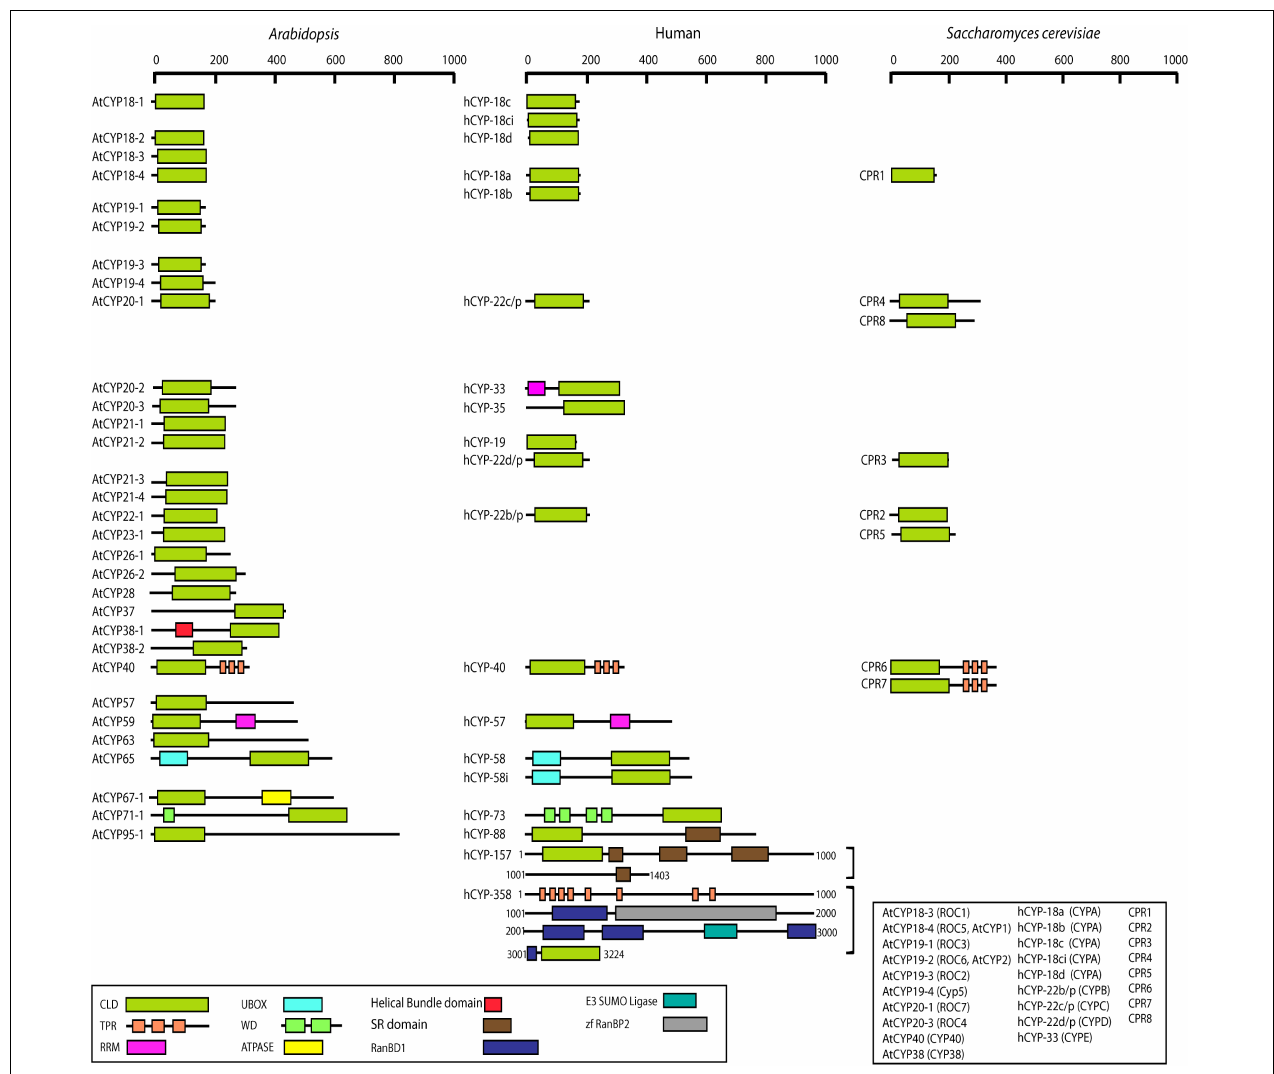
FIGURE 1 | Comparative analysis of domain architecture of Arabidopsis cyclophilins with their orthologs in human and Saccharomyces cerevisiae . The amino acid residues that define the protein domains are designated according to Galat (2004), Wang and Heitman (2005), Kumari et al. (2015), and Schiene-Fischer (2015). For Arabidopsis cyclophilins that may have alternatively spliced forms, the domain architecture is shown for only a single variant. CLD, cyclophilin-like domain; RRM, RNA recognition motif; TPR, tetratricopeptide repeat; U-box, U box domain; WD40, WD40 repeat; RanBDl, Ran binding protein 1 domain; zf RanBP, Zn-finger, Ran-binding; SR, Serine arginine rich domain. The nomenclature and alternative protein names are given in the box. Scale bar represents the length of amino acid